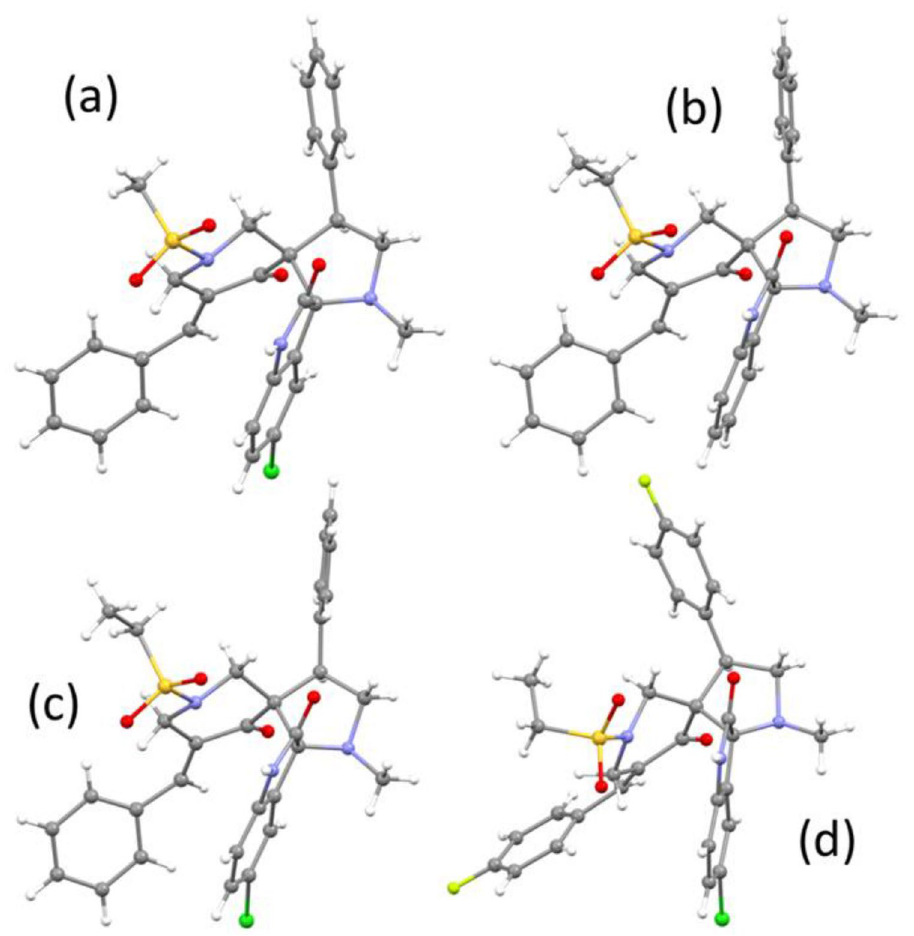
Figure 5. The molecular structures of ( a ) 6b , ( b ) 6c ( c ) 6d and ( d ) 6h .